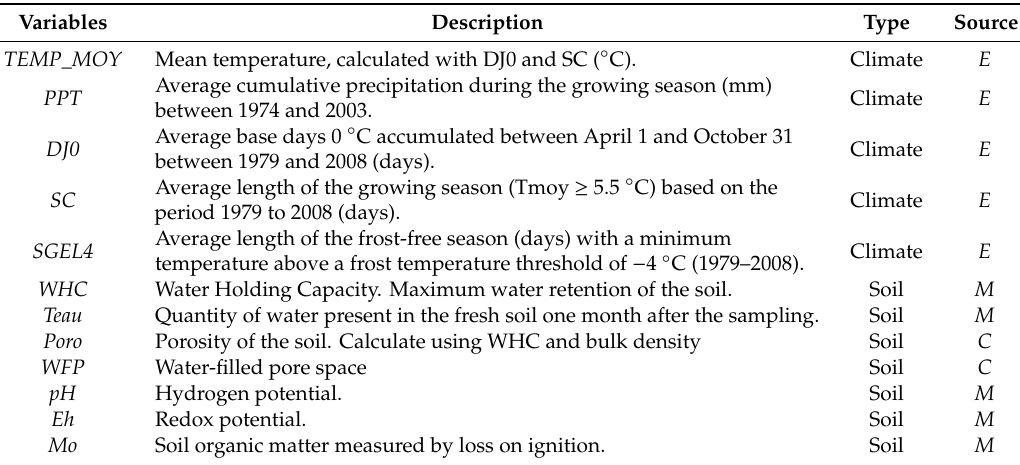
Table 1. Description of abiotic